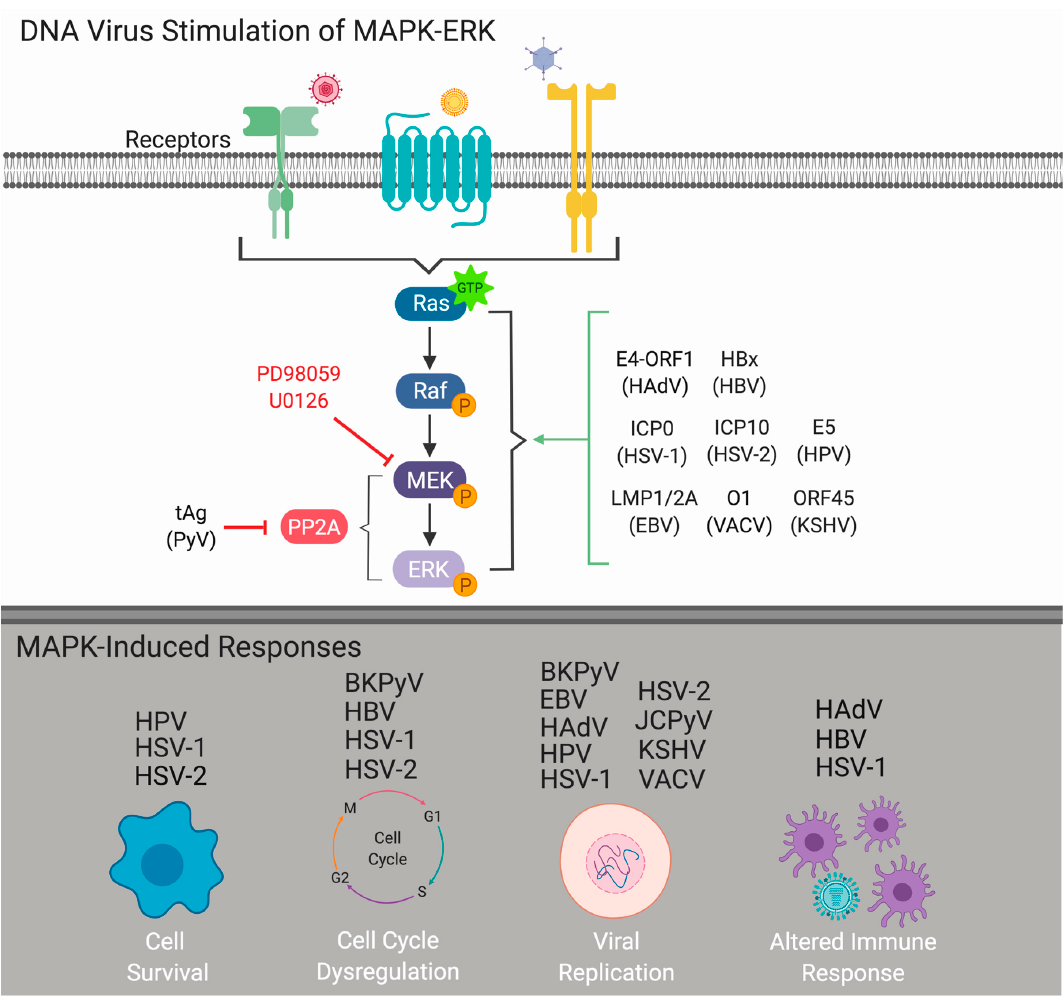
Figure 1. DNA virus stimulation of the mitogen-activated protein kinase extracellular signal-regulated kinase (MAPK-ERK) cascade. Viral stimulation of the MAPK-ERK pathway induces sequential phosphorylation of the core kinase of the MAPK-ERK signaling mechanism: Raf, MAPK / ERK kinase (MEK), and ERK. Upon activation of this pathway, multiple responses can be induced to help facilitate viral infection including promoting cell survival, cell cycle dysregulation, enhancement of viral replication, or alterations to host immune responses. Abbreviations: BK polyomavirus (BKPyV), Epstein-Barr virus (EBV), human adenovirus (HAdV), hepatitis B virus (HBV), human papillomavirus (HPV), herpes simplex virus 1 (HSV-1), herpes simplex virus 2 (HPV-2), JC polyomavirus (JCPyV), Kaposi’s sarcoma-associated virus (KSHV), vaccinia virus (VACV). Created with BioRender.